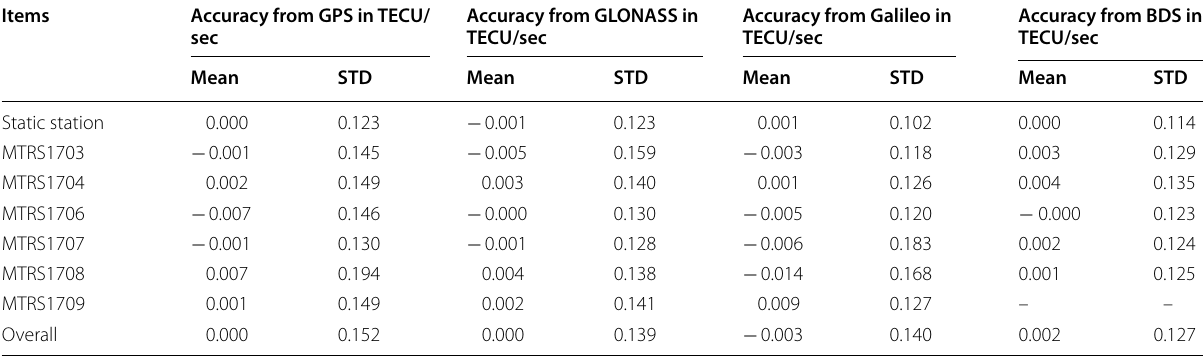
Table 3 Statistics of mean and standard deviation of the TECR values derived from carrier phase observations collected from different GNSS systems at both static station and moving MTR train Accuracy from GPS in TECU/ Accuracy from GLONASS in Accuracy from Galileo in Accuracy from BDS in sec TECU/sec TECU/sec